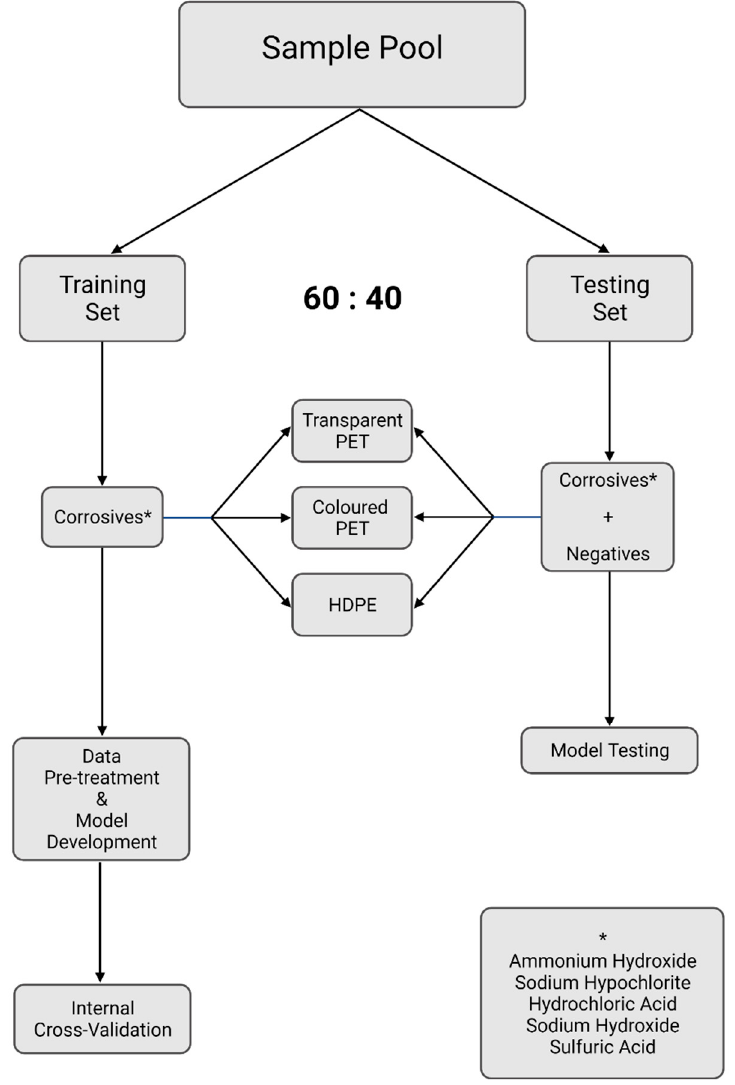
Figure 1. Experimental workflow from sample collection to model performance evaluation. Created with BioRender.com. * presents corrosive